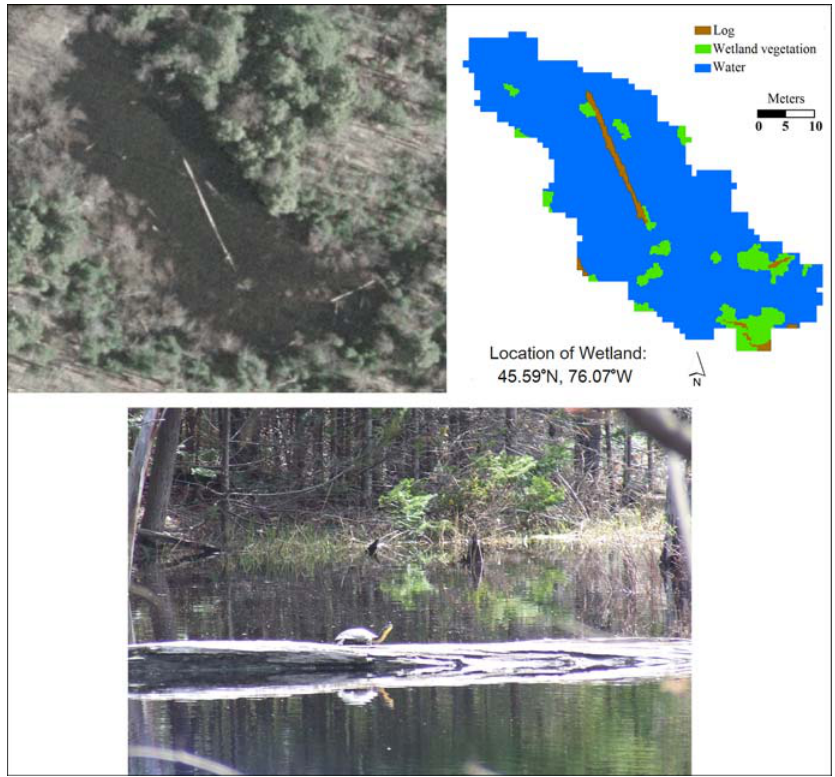
habitat features (upper right), a Blanding’s turtle observed in May 2009